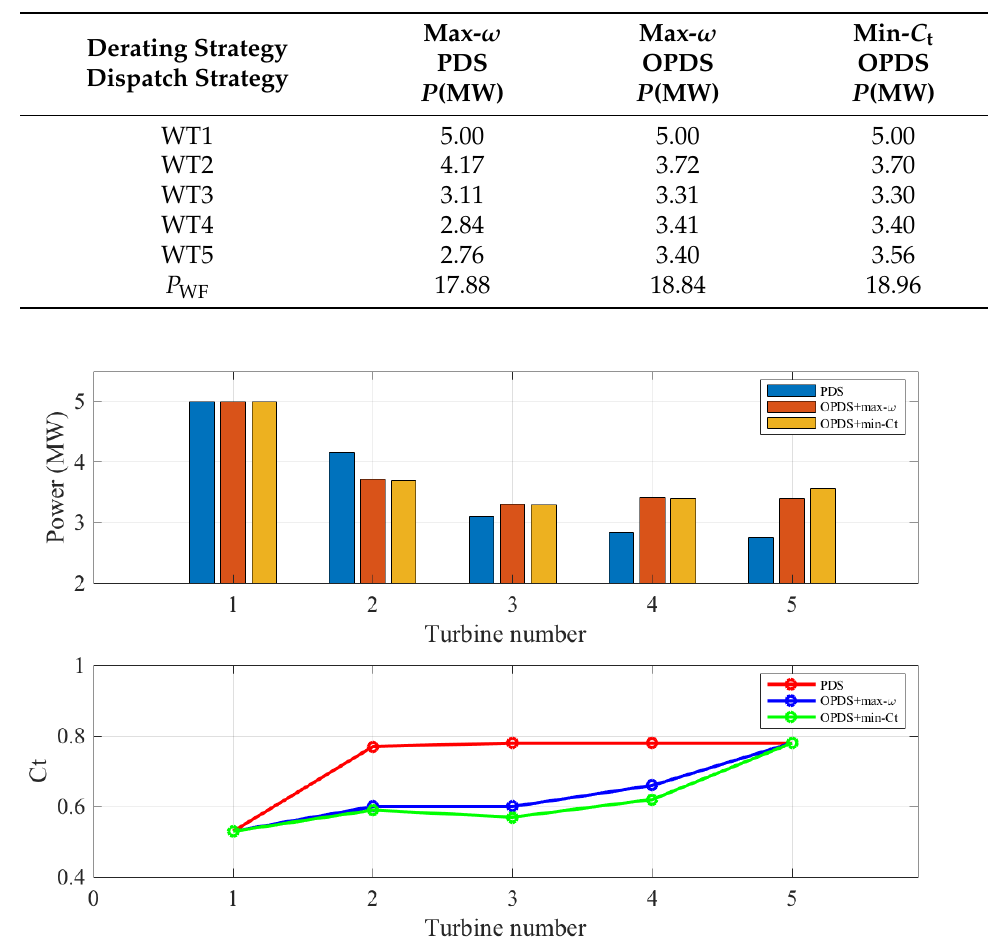
Table 2. Wind farm power with different strategies.